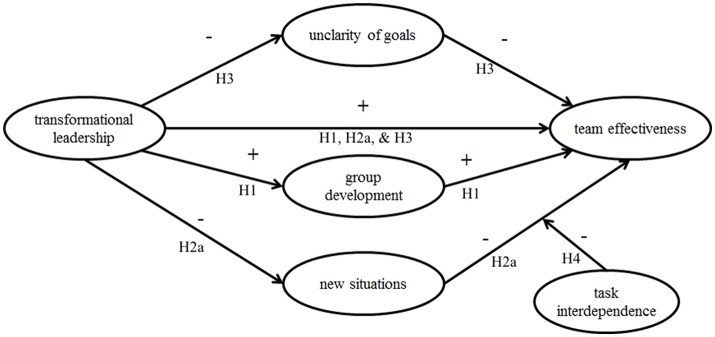
Model 2, representing the hypotheses H1, H2a, H3, and H4.